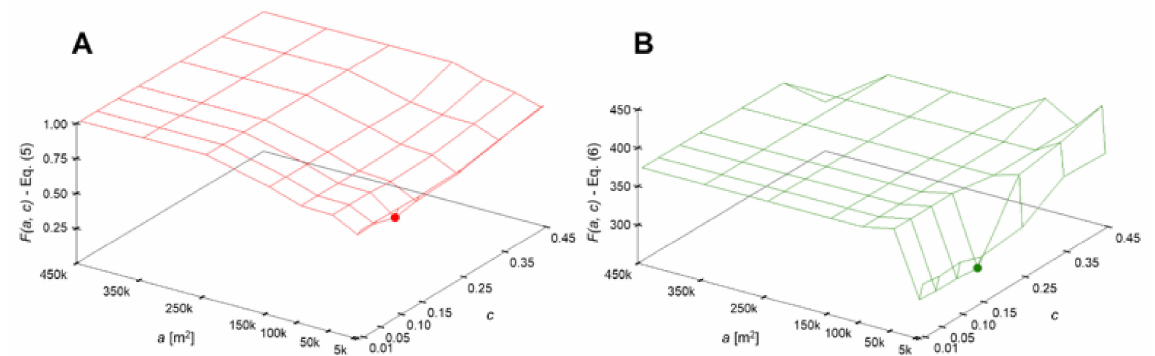
Figure 6. Active deformation slope units (ADSUs) optimization metrics, calculated as a function of the software r.slopeunits [47] input parameters a and c , for all the possible ( a , c ) combinations. ( A ) Values of the metric F ( a, c ) de- fined by Equation (5): the optimal values are found in correspondence with the minimum value of Equation (5), indicated with a red dot. ( B ) Values of the metric F ( a, c ) defined by Equation (6): the minimum value of Equation (6) is indicated with a green